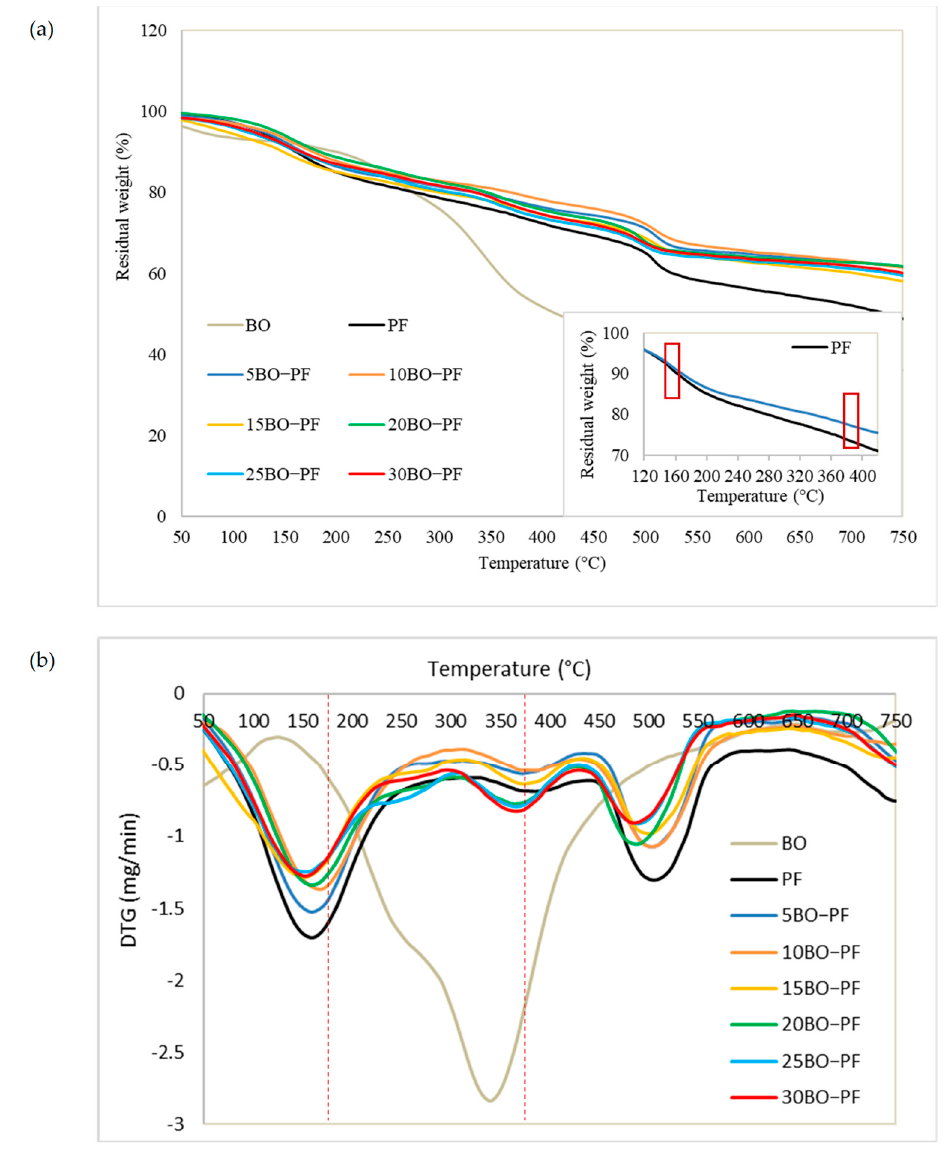
Figure 8. ( a ) TG and ( b ) DTG thermograms of the BO, PF and BO − PF resins with 5 to 30% phenol substitution rate, and the small box showing the TG thermogram of PF and 5BO − PF resins at 160 and 390 °C. Table 3. Residual weight of PL, BO, PF, PL − PF resins and BO − PF resins.